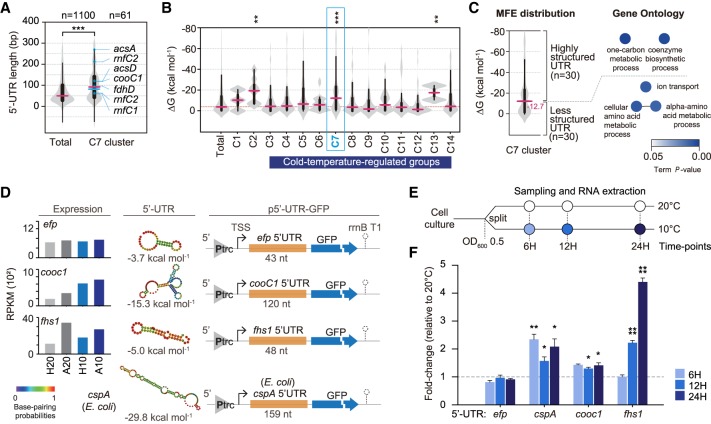
Low-temperature-responsive 5′-UTRs control the expression of acetogenesis-associated genes. (A) Comparison of the length distributions of 5′-UTRs between the total and C7 groups. The significance of differences was assessed by the Wilcoxon-Mann-Whitney test (***, P < 0.001). See also Supplemental Figure S6. (B) Comparison of the minimum folding free energy (MFE) distribution between the groups of DEG. Violin plots show median and quartile ranges of calculated MFEs. Secondary structures of a representative set of the mRNAs were predicted using the ViennaRNA RNAfold (Lorenz et al. 2011). The significance of differences was assessed by the Wilcoxon-Mann-Whitney test (**, P < 0.01; ***, P < 0.001). (C) Minimum folding free energy (MFE) distribution of C7 group and their Gene Ontology term enrichment analysis. Violin plots show median and quartile ranges of calculated MFE. Secondary structures of a representative set of the mRNAs were predicted using ViennaRNA RNAfold software. Enriched GO terms, including biological process, molecular function, and cellular component, were represented together as nodes. A Bonferroni-corrected P < 0.05 was considered the cut-off criterion. Term enrichment significance is represented by color. (D) Design of plasmid-based reporters for characterization of regulatory 5′-UTR regions. (Left panel) The transcriptional level of the efp, cooc1, and fhs1 genes under the four growth conditions; (middle panel) secondary structure of each 5′-UTR. Structure and MFE were predicted using the ViennaRNA RNAfold software. (Right panel) Schematic illustration of the reporter gene constructs. Each segment of the gene 5′-UTRs of genes was fused to GFP under the constitutive trc promoter. Yellow boxes represent the specific mRNA 5′-UTRs. The sequence for the 5′-UTR of cspA was obtained from the genome of E. coli strain MG 1655 (NC_000913.3). (E) The assay design is shown. (F) Assays of 5′-UTR of efp, cooc1, fhs1, and cspA at 10°C and 20°C, respectively. The graph shows fold-changes in the GFP transcript abundance. Each value is the mean of three replicates in independently repeated experiments, and error bars show ±SEM. The gyrA gene was used as the reference (*) P < 0.05; (**) P < 0.01; (****) P < 0.0001 (Student's unpaired t-test).